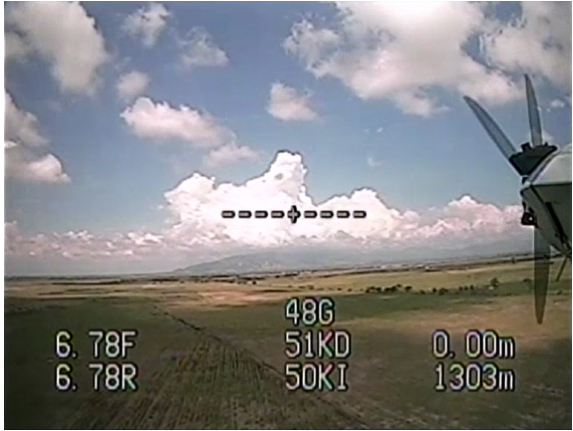
Figure 1. Captured image of a video stream from a camera mounted on an unmanned aerial vehicle (UAV). The image resolution is 720 width and 480 height at a 30 frames per